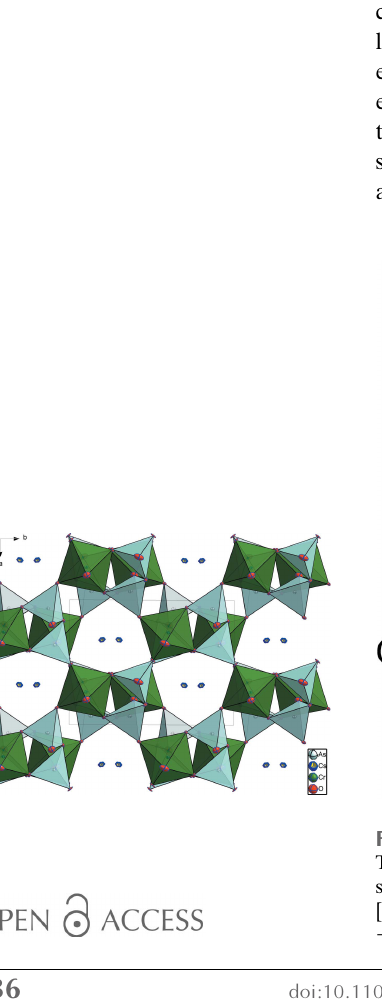
(cid:2) y , 1 + z ; (ii) 2 (cid:2) x , 1 2 2 (cid:2) z + y , 3 2 2